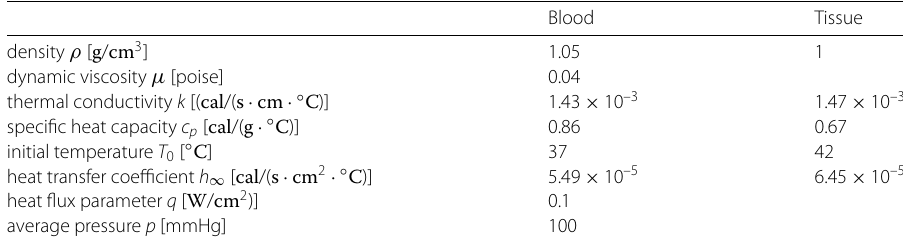
Table 1 Model parameters. Fluid properties at 37 ° C [1, 6]